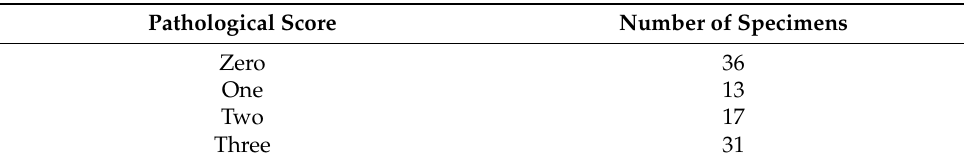
Table 2. Pathological scores for CD22 expression in TNBC